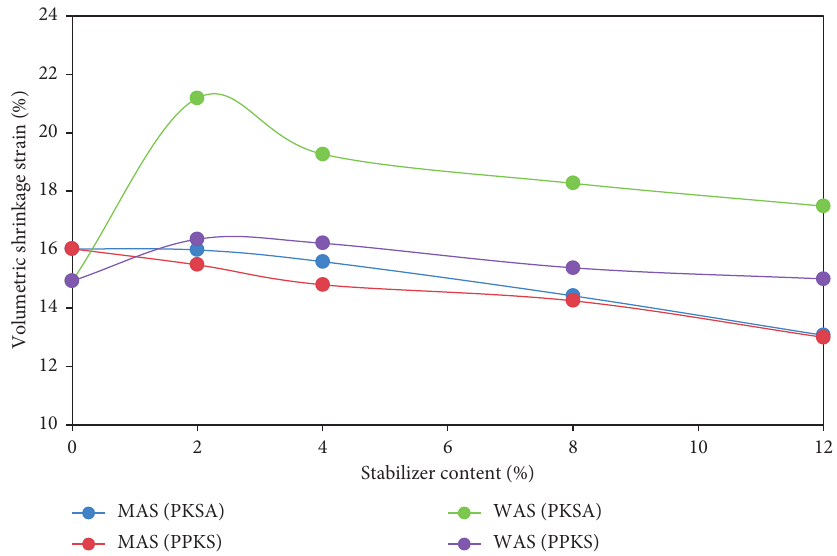
Figure 12: Volumetric shrinkage strain of the treated shale at MAS and WAS compactive